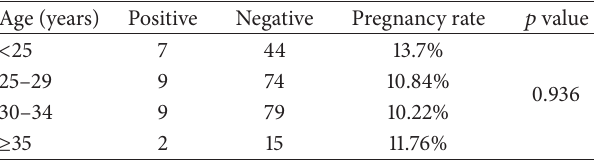
Table 2: Age-wise description of IUI